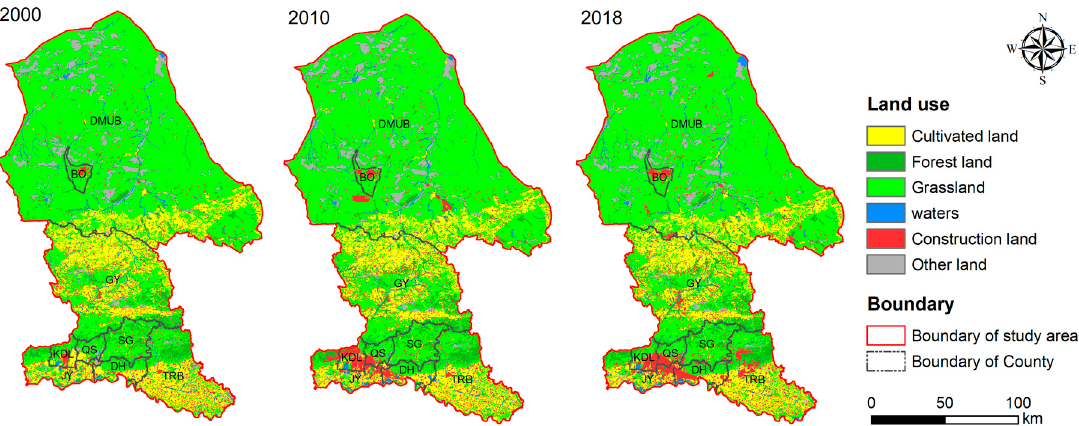
Figure 3. Spatial pattern of land use in Baotou from 2000 to 2018 (note: DMUB, BO, GY, KDL, JY, QS, SG, DH, and TRB refer to Darhan Muminggan United Banner, Bayan Obo, Guyang, Kundulun, Jiuyuan, Qingshan, Shiguai, Donghe, and Tumote Right Banner,